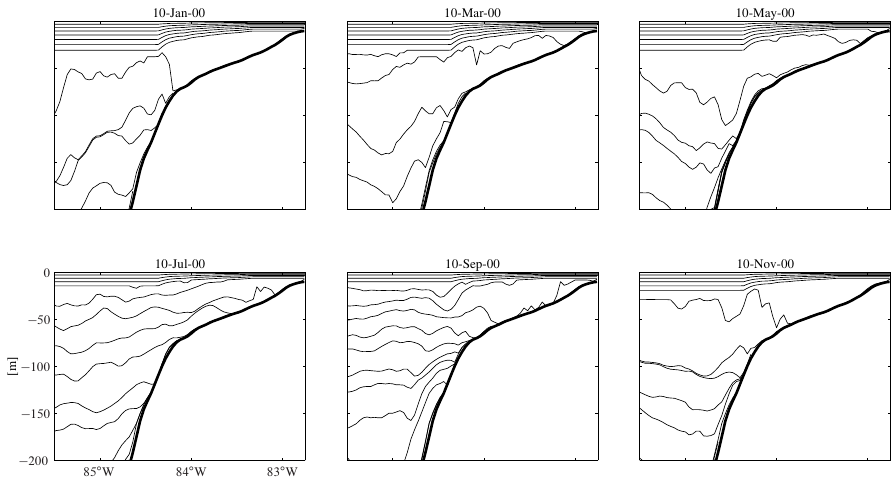
Fig. 2. Transect across the West Florida Shelf (WFS) at 27.5 ◦ N showing on selected dates along 2004 various layers of the Hybrid- Coordinate Ocean Model (HYCOM), which is employed in the Lagrangian calculations. The thin curves indicate the boundaries between contiguous layers, which are labeled k = 1 , 2 ,... from the top down throughout the paper. The thick curve indicates the bottom topography.